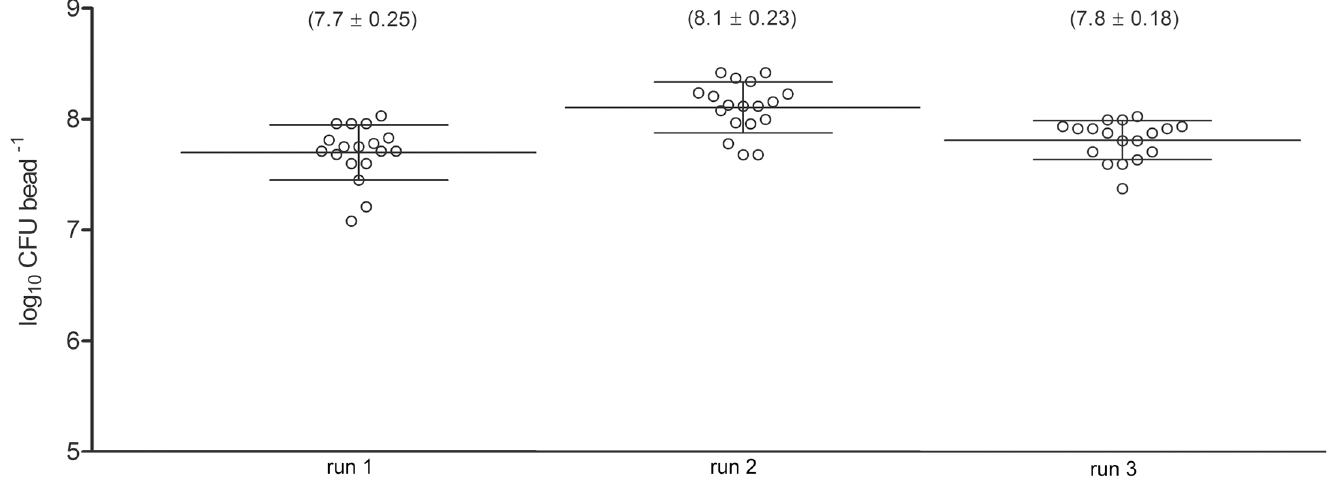
Fig 3. Testing for repeatability. CFU counts of three independent experiments with untreated biofilm on glass beads. (The horizontal lines through the data points represent mean and standard deviation).